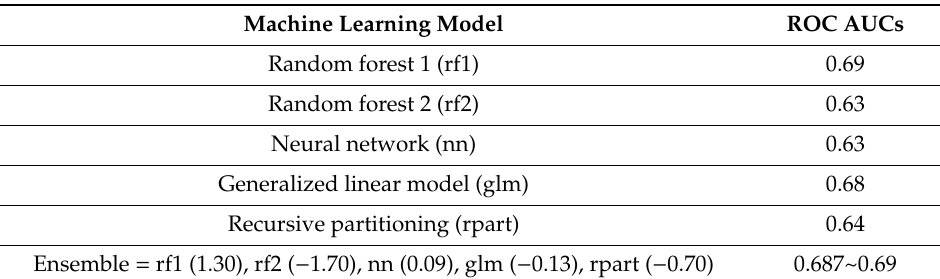
Table 3. Area under the receiver operator curve for models predicting critical limb